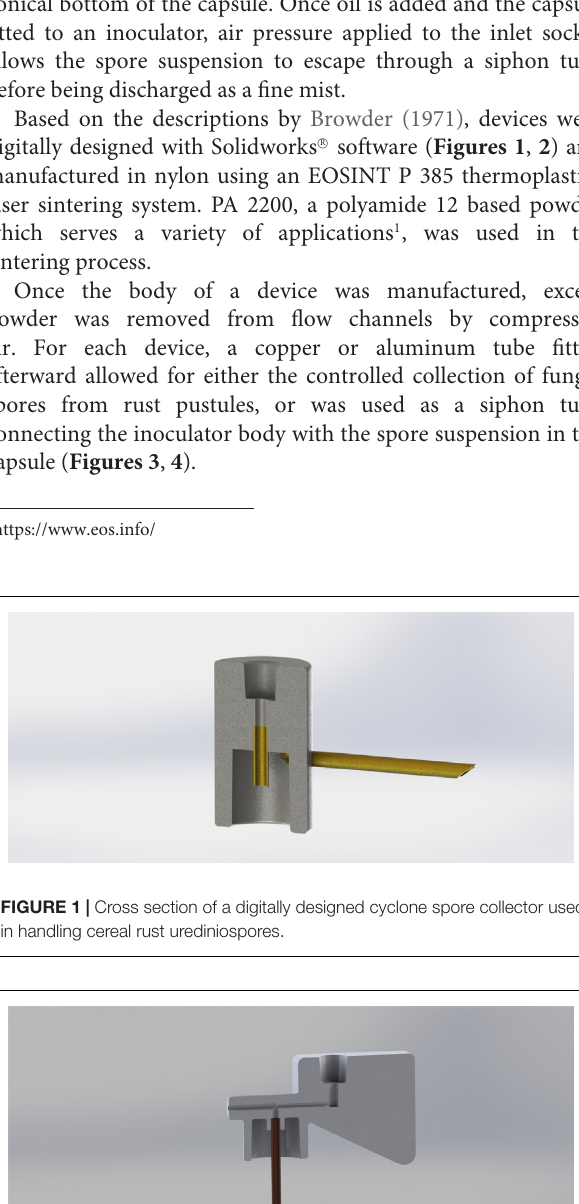
Frontiers in Plant Science |